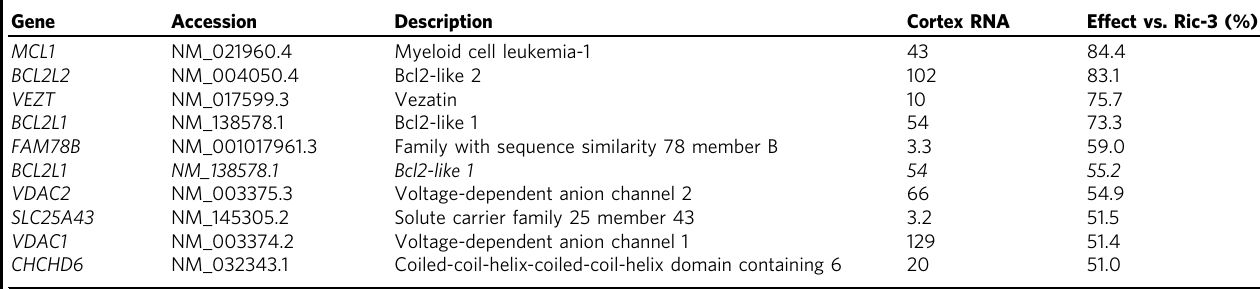
Table 1 cDNAs that enhance surface α -Bgt staining of α 7 nAChRs in HEK293T cells